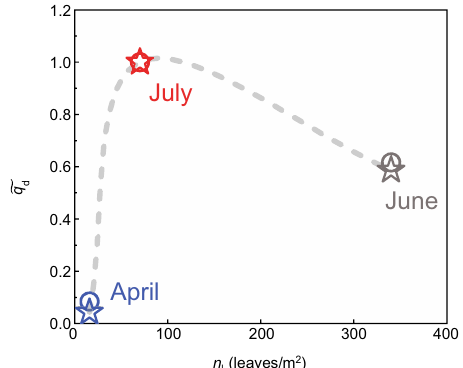
Fig. 5 | Comparison between measured (stars) and simulated (circles) sedi- mentation rate. The gray dashed curve was added to emphasize the nonlinear relationship between net deposition rate and vegetation density. Note that each measurement occurred under a different water slope (Table 1), which was asso- ciated with a different modeled curve of f q d versus vegetation density. The indivi- dual curves are shown in Supplementary